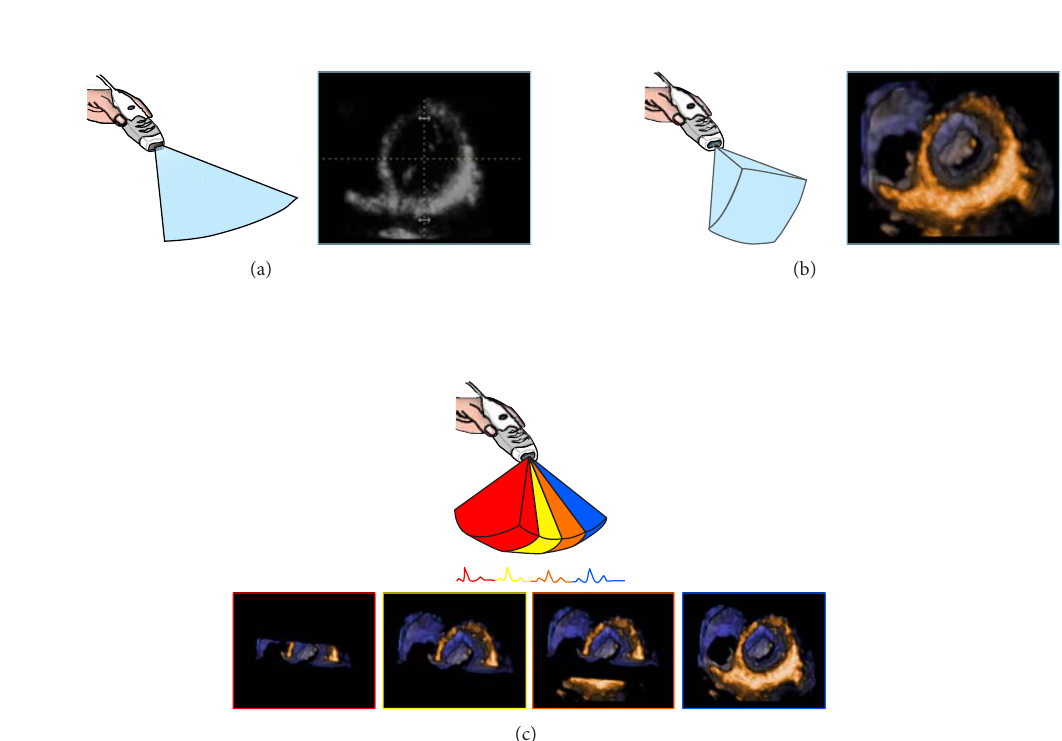
Figure 4: Schematic representation of two-dimensional (i.e., tomographic (a)) and single-beat three-dimensional (i.e., volumetric (b)) of the left ventricular short axis at mitral valve level. Volumetric rendering displays many more details and allows better appreciation of spatial relationshipamongcardiacstructures.(c)showsthemultibeatacquisitionmodality:twotosixconsecutivesingle-beatsubvolumesarestitched together to obtain a full-volume with higher spatial and temporal